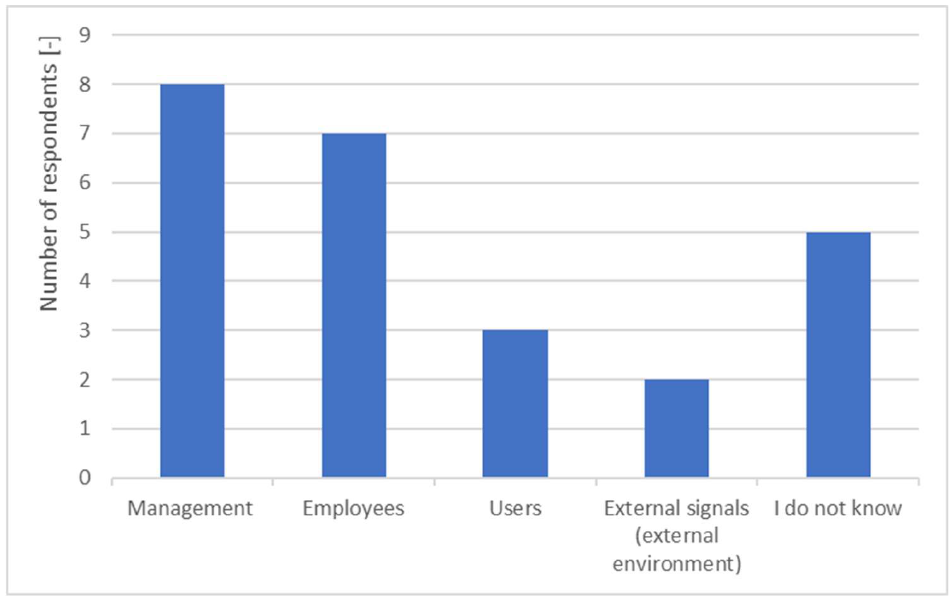
Figure 6. People responsible for creating open innovations in companies in the shared mobility market.